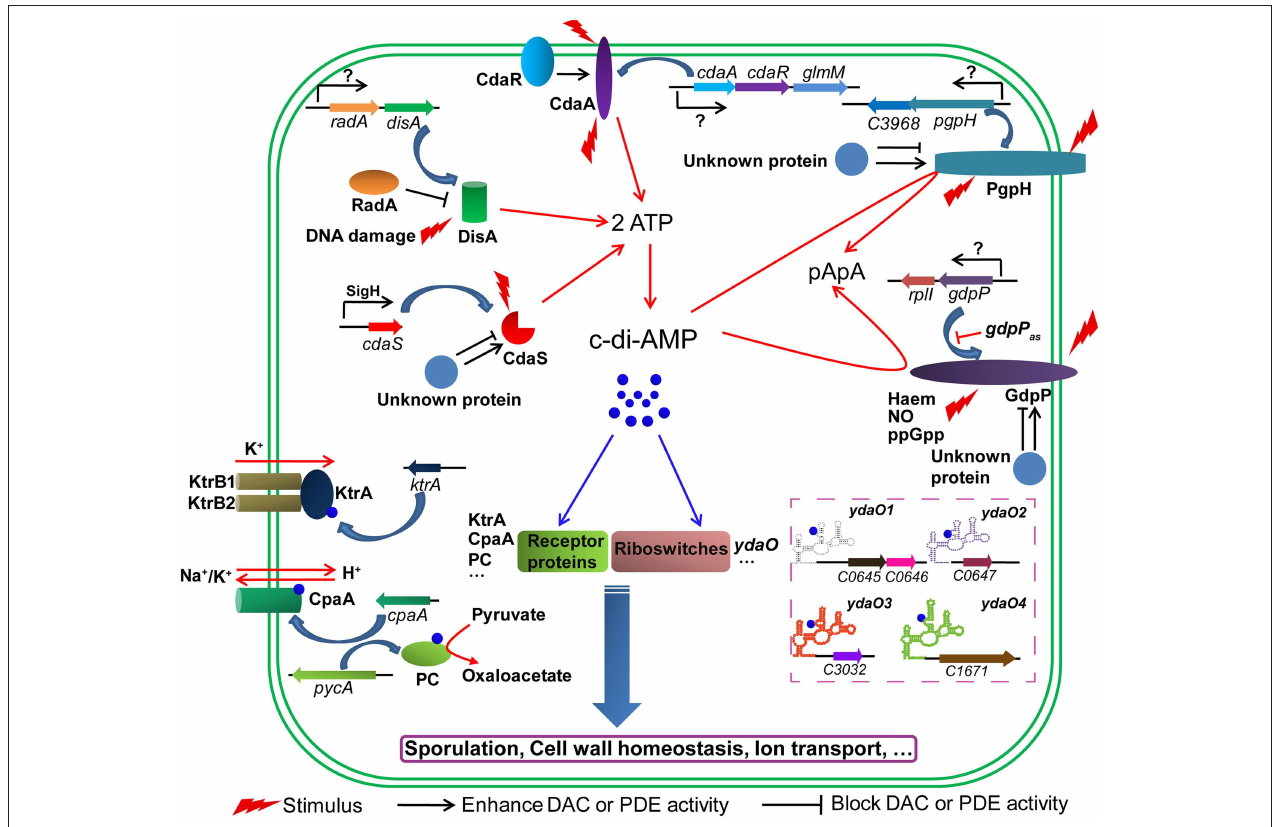
FIGURE 9 | Proposed signaling network mediated by c-di-AMP in B. thuringiensis . c-di-AMP is synthesized by DACs (DisA, CdaA and CdaS) and hydrolyzed by c-di-AMP-specific PDEs (GdpP and PgpH). Its level is spatially and temporally controlled by factors that affect these enzymes with respect to transcription, translation and enzymatic activity levels. c-di-AMP binds to receptor proteins and riboswitches and regulates various physiological processes. RadA, DNA repair protein; CdaR; CdaA regulator; GlmM, phosphoglucosamine mutase; RplI, ribosomal protein L9; gdpP as , cis -acting antisense RNA for gdpP ; KtrA, potassium uptake protein; CapA, a predicted cation/proton antiporter; PC, pyruvate carboxylase; ydaO , c-di-AMP riboswitch, the structure of four predicted c-di-AMP riboswitches are shown; KtrB, a potassium uptake protein, interacts with KtrA to form a complex for potassium